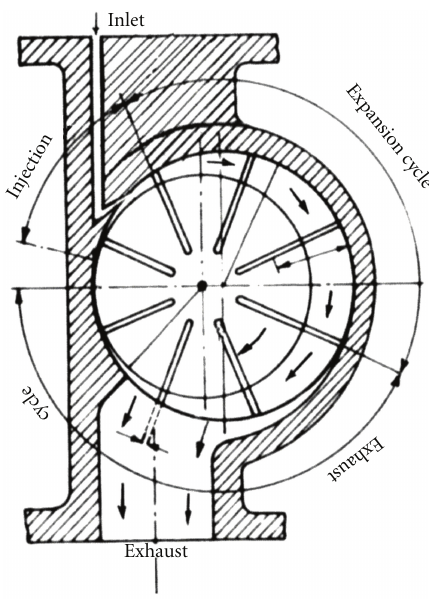
Figure 1: Air-turbine